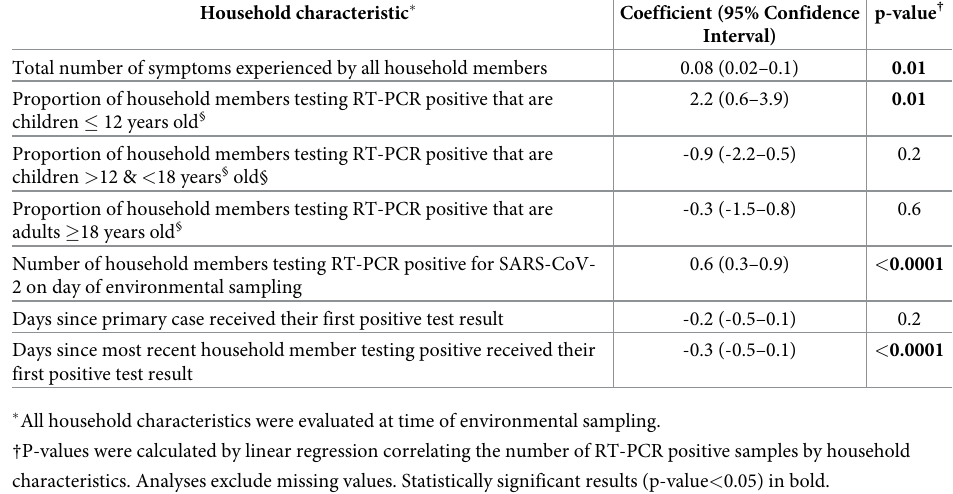
Table 4. Household characteristics, and univariate analysis of association between continuous household charac- teristics and number of positive environmental samples. Household characteristic � Coefficient (95% Confidence